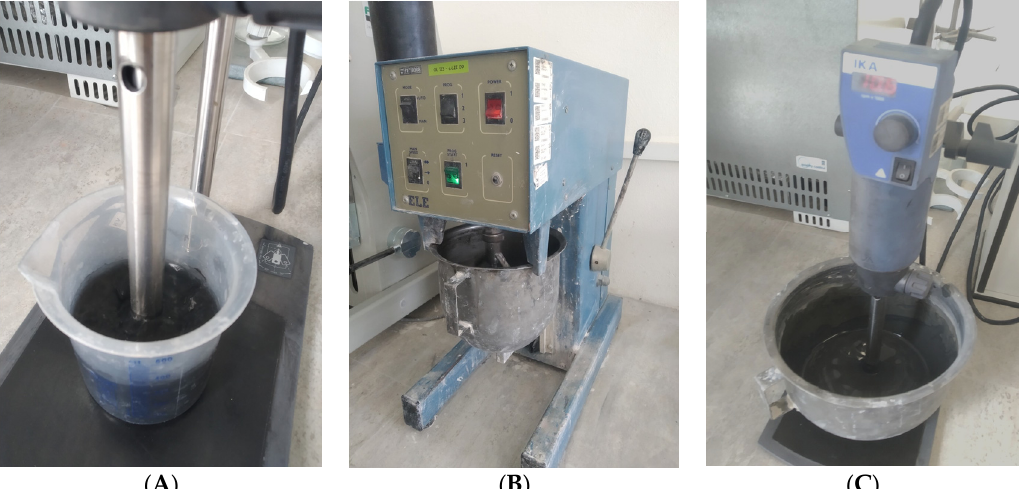
Figure 1. Preparation of composites: ( A ) dispersion of graphene in MgCl 2 solution; ( B ) ordinary mixing of MOC (magnesium oxychloride cement) paste; ( C ) second step of homogenization using Ultra-Turrax.